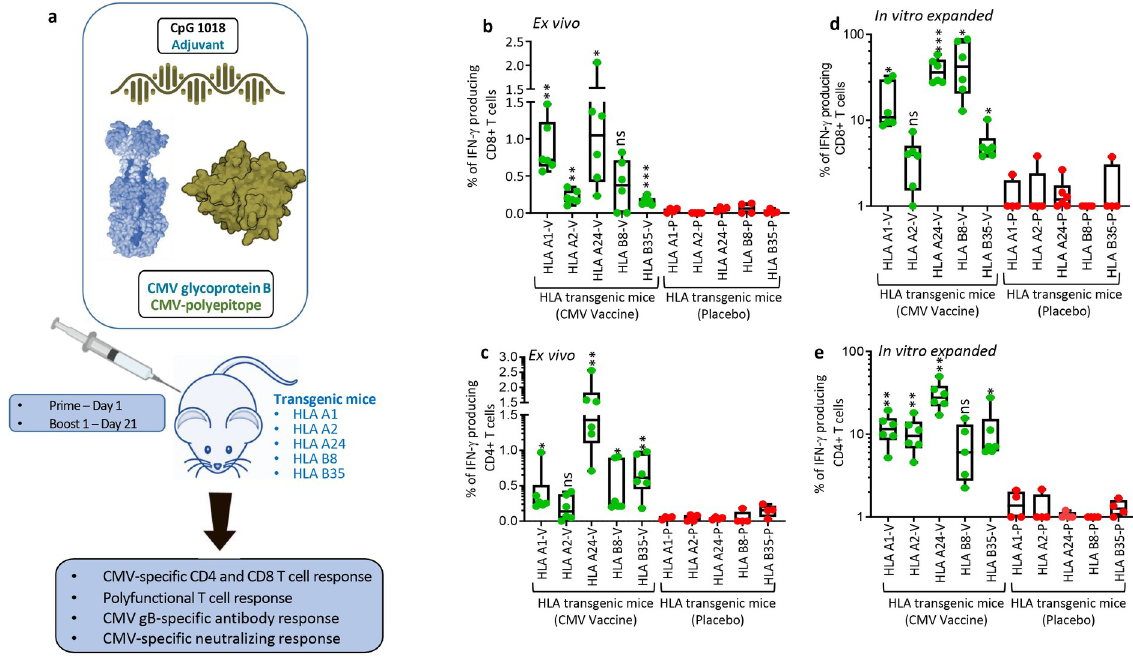
Fig 3. CMV vaccine immunogenicity evaluation in multiple HLA expressing mice: (a) Schematic outline of CMV vaccine immunogenicity evaluation in HLA expressing mice. CMV vaccine formulation included CMVpoly (30 μ G) and gB (5 μ g) proteins admixed with CpG1018 (50 μ g) adjuvant. Five different human HLA expressing mice (HLA A1, A2, A24, B8 and B35) were immunised subcutaneously with CMV vaccine (N = 6) or CpG1018 alone (N = 4) as a placebo control on days 0 and 21 and CMV-specific cellular and humoral immune responses were assessed on day 28. (a and b) Ex vivo CMV-specific CD8 + and CD4 + T cell responses in HLA A1, A2, A24, B8 and B35 expressing mice immunized with CMV vaccine. Splenocytes from immunized mice were stimulated with HLA matched CD8 + T cell epitopes (Panel a) or CMV gB overlapping pepmix (Panel b) and then assessed for IFNg expression using intracellular cytokine assays. (d and e) In vitro expansion of CMV-specific CD8 + and CD4 + T cells from splenocytes of immunized mice following in vitro stimulation with HLA matched CD8 + T cell epitopes (Panel d) or CMV gB overlapping pepmix (Panel e). Splenocytes were stimulated with HLA matched CD8 + CMV T cell epitopes or gB overlapping pepmix and then cultured for 10 days in the presence of IL-2. After incubation these T cells were assessed for IFNg expression using intracellular cytokine assays. Error bars are SEMs. Statistics are indicated in comparison with control group. If statistics are not indicated, then the comparison was not significant (ns). P vales were also calculated between the vaccinated mice. In Fig 3B HLA A24 vs HLA A1 p = 0.61, HLA A24 vs HLA A2 p = 0.029, HLA A24 vs HLA B8 p = 0.06 and HLA A24 vs HLA B35 p = 0.02. In Fig 3C HLA A24 vs HLA A1 p = 0.004, HLA A24 vs HLA A2 p = 0.02, HLA A24 vs HLA B8 p = 0.006 and HLA A24 vs HLA B35 p = 0.01. In Fig 3D HLA A24 vs HLA A1 p = 0.009, HLA A24 vs HLA A2 p = 0.001, HLA A24 vs HLA B8 p = 0.52 and HLA A24 vs HLA B35 p = 0.001. In Fig 3E HLA A24 vs HLA A1 p = 0.009, HLA A24 vs HLA A2 p = 0.006, HLA A24 vs HLA B8 p = 0.003 and HLA A24 vs HLA B35 p = 0.009. � P < 0.05; �� P < 0.01; ��� P < 0.001 by Welch’s t